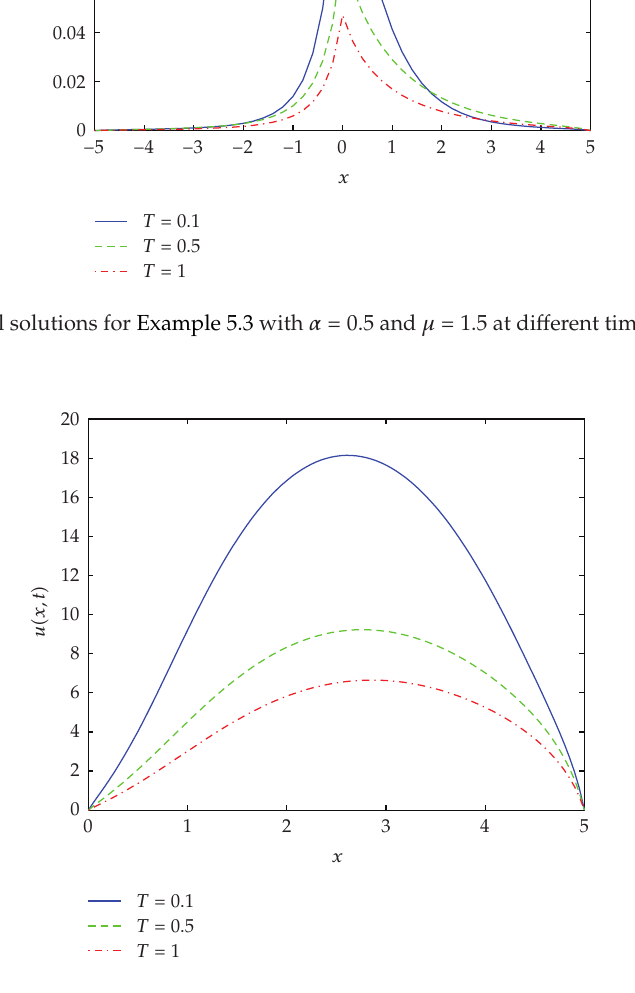
Figure 8: Numerical solutions for Example 5.4 with α (cid:7) 0 . 8 and μ (cid:7) 1 . 6 at di ff erent times T (cid:7) 0 . 1 , 0 . 5 , 1 .